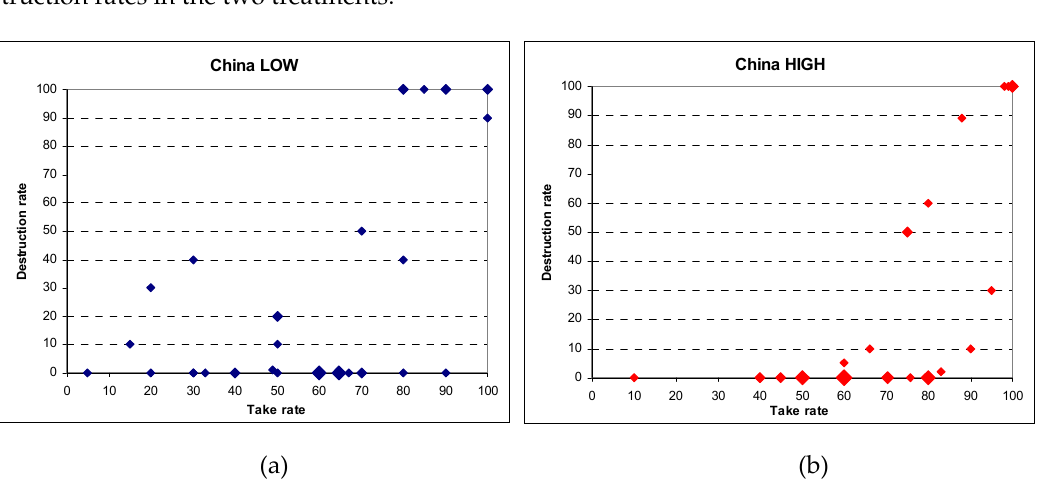
Figure 1. Take rates and destruction rates in CHINA LOW ( a ) and CHINA HIGH ( b ). Note: The size of symbols is proportional to the underlying number of observations.